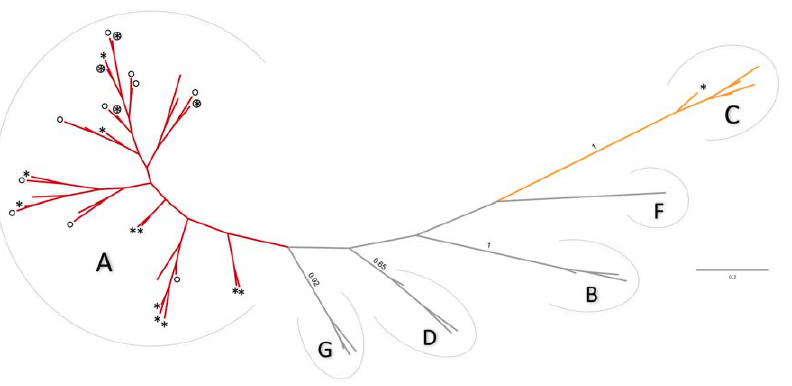
Figure 2. Mitochondrial diversity of Corsican goats compared to world-wide goats diversity. Ancient (circles) and current (stars) Corsican sequences have been used with 20 sequences of reference corresponding to all haplogroups described up to now [14] to reconstruct a Bayesian phylogenetic tree using a GTR + I + G model of evolution (see text). Only a single sequence by haplotype has been used, so haplotypes in common between medieval and today periods are indicated by both a circle and star. Only posterior probabilities higher than 0.6 are indicated.